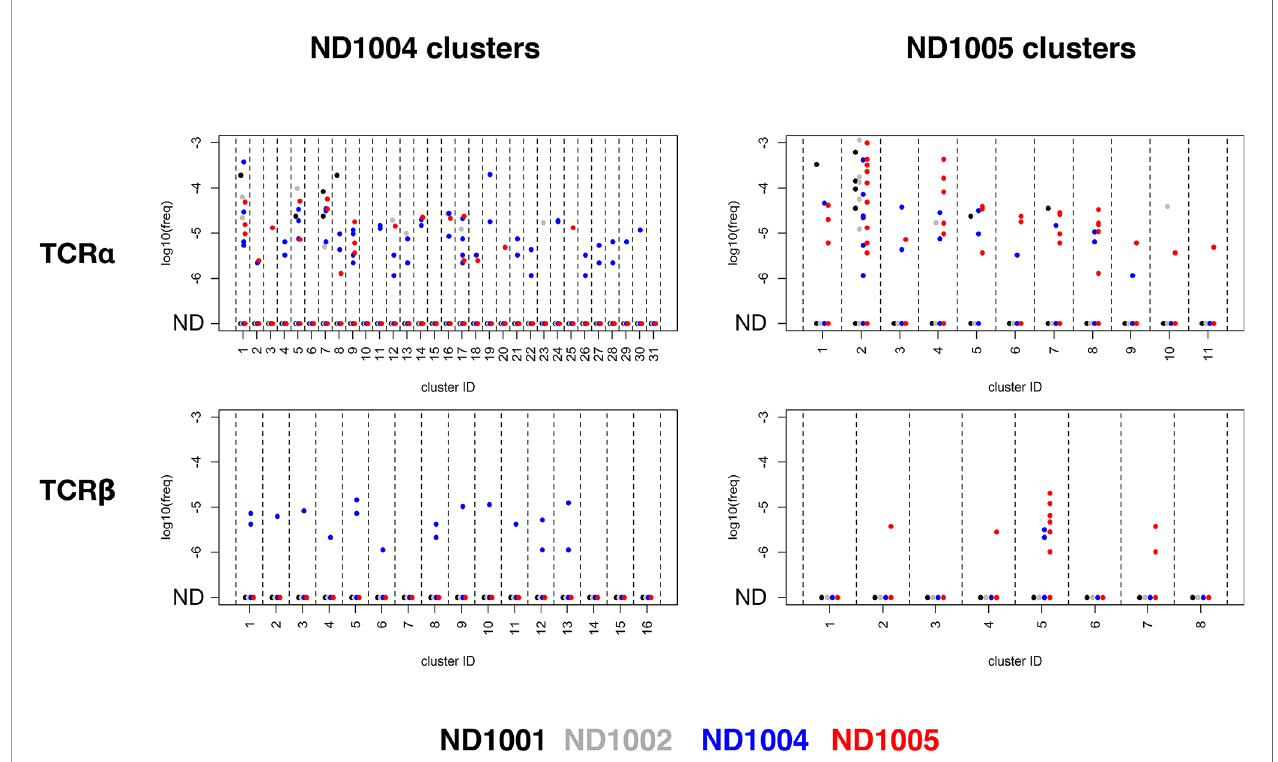
FIGURE 6 | Speci fi city of rare antigen-speci fi c TCR b , but not TCR a , clonotypes within deep unenriched repertoires. TCR a and b libraries were prepared from uncultured PBMCs from 4 healthy subjects (ND1001, ND1002, ND1004, and ND1005), and deeply sequenced to generate an average of >1.3M clonotype counts per sample. Clonotypes within each of the TCR a and b CETs identi fi ed previously in ND1004 and ND1005 (Figure 5) were queried against these 4 deep, uncultured datasets by matching for nucleotide-level sequence identity. Plots show log10(frequency) of sequences in the 4 uncultured datasets (colored by donor) and organized by chain type (upper/lower), CET donor (left/right), and CET grouping (x-axis